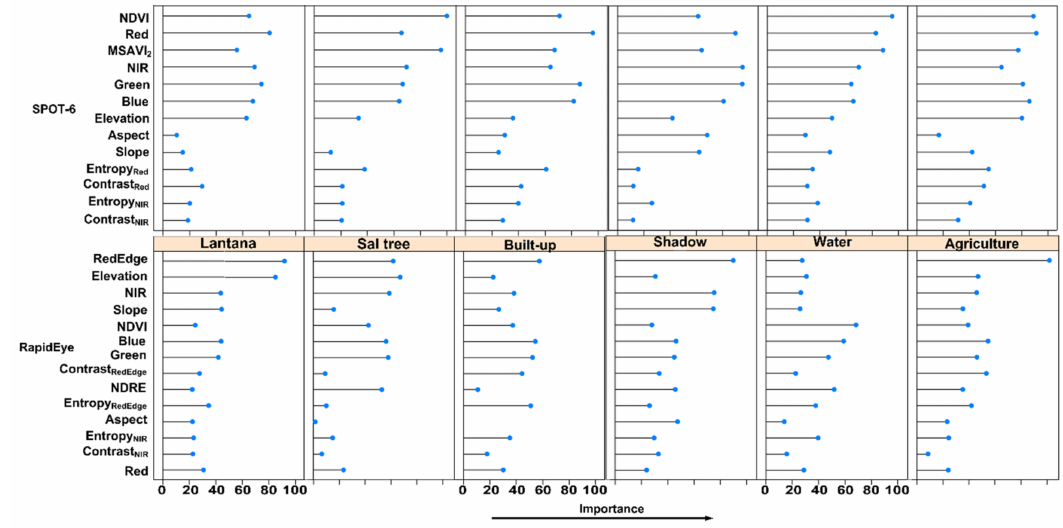
Figure 5. Variable importance shown as mean accuracy decrease (% decrease in overall accuracy) for SPOT-6 and RapidEye-based classification.